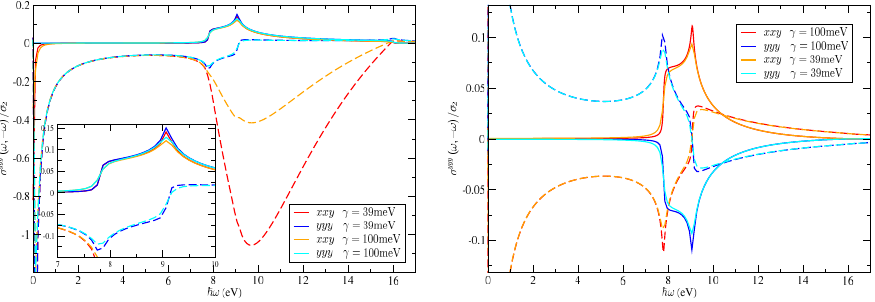
Figure 2. Photogalvanic effect in dGG (left) and GG (right). The gap is ∆ = 7 . 78 eV. Lattice size: L = 2048 , Fermi energy ε F = 0 eV. The solid curves represent the real part of the conductivity and the dashed curves the imaginary